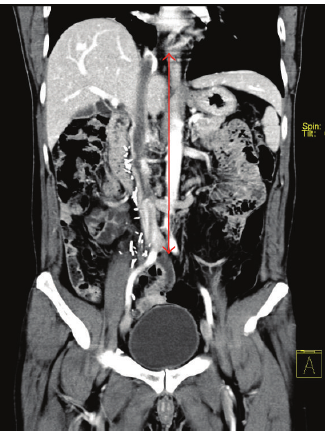
Figure 1: Reformatted coronal CT image demonstrating contiguous tumour thrombus in the inferior vena cava extending to the junction of the right atrium.